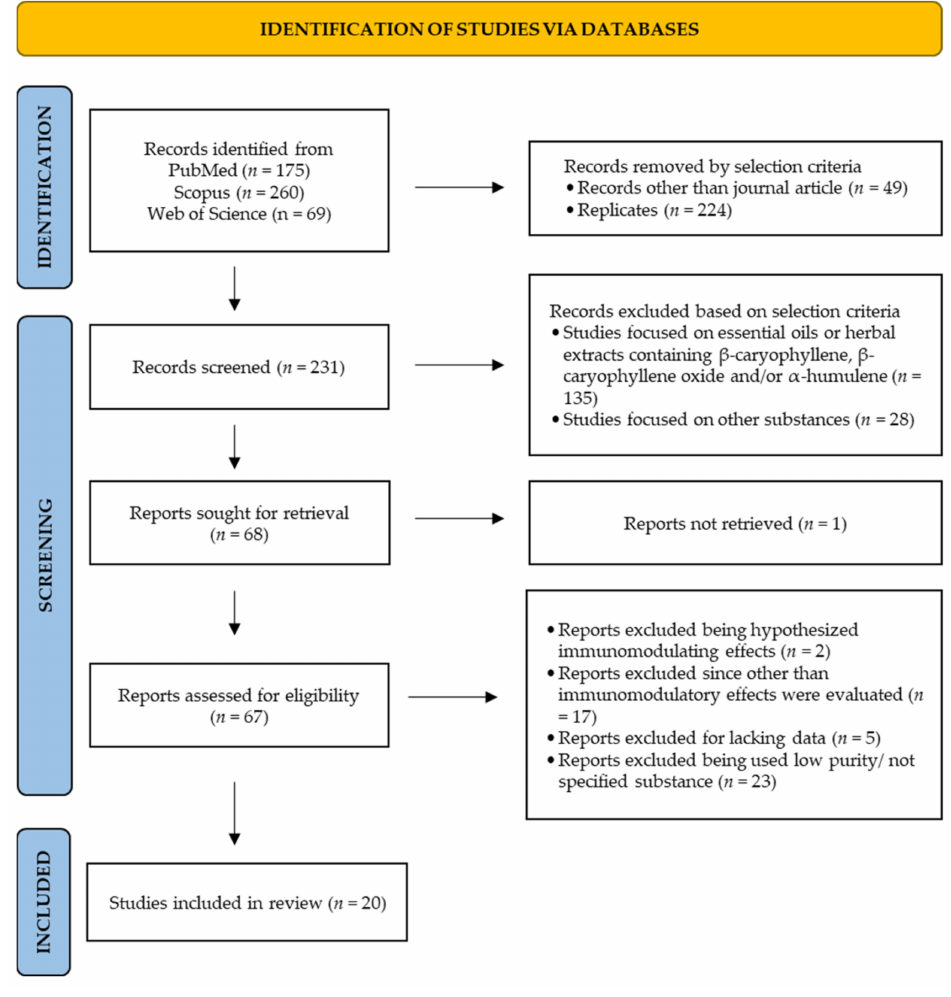
Figure 1. Study selection by PRISMA flow diagram for the immunomodulatory activity of caryophyl- lane